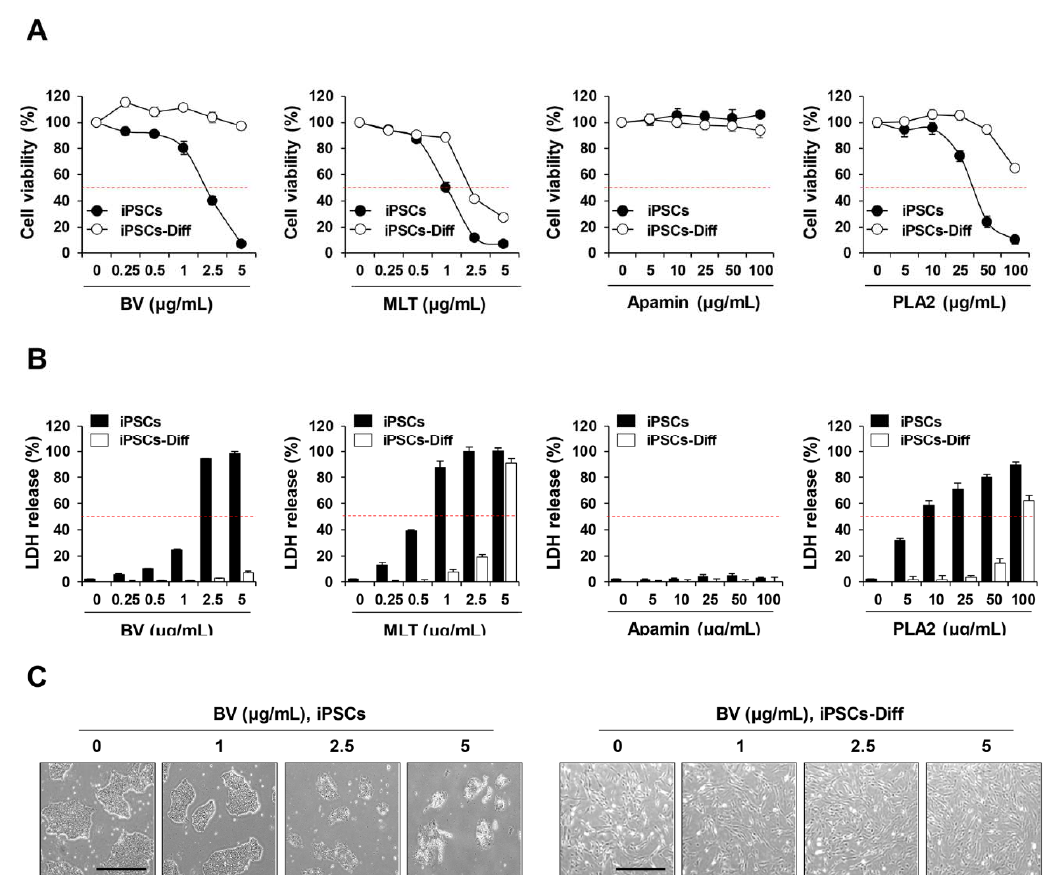
Figure 1. Effects of bee venom (BV), melittin (MLT), apamin, and phospholipase A2 (PLA2) on the cell viability and LDH release in iPSCs and iPSCs ‐ Diff. ( A ) iPSCs and iPSCs ‐ Diff were seeded on 24 ‐ well culture plates and then treated with the indicated concentrations of BV, MLT, apamin, and PLA2. After 24 h, viable cells were determined after crystal violet staining. Relative cell viability compared to untreated cells was calculated and expressed as means ± SD from triplicate samples. ( B ) iPSCs and iPSCs ‐ Diff were treated with the indicated concentrations of BV, MLT, apamin, and PLA2 for 24 h and then LDH levels in culture supernatants were measured. The percentage LDH release calculated based on the background control and high control was expressed as means ± SD from triplicate samples. ( C ) iPSCs and iPSCs ‐ Diff seeded in 12 ‐ well culture plates were incubated in the presence of BV at 1, 2.5, and 5 μ g/mL. At 24 h post ‐ treatment, cells were photographed under an inverted microscope. Scale bar = 100 μ m